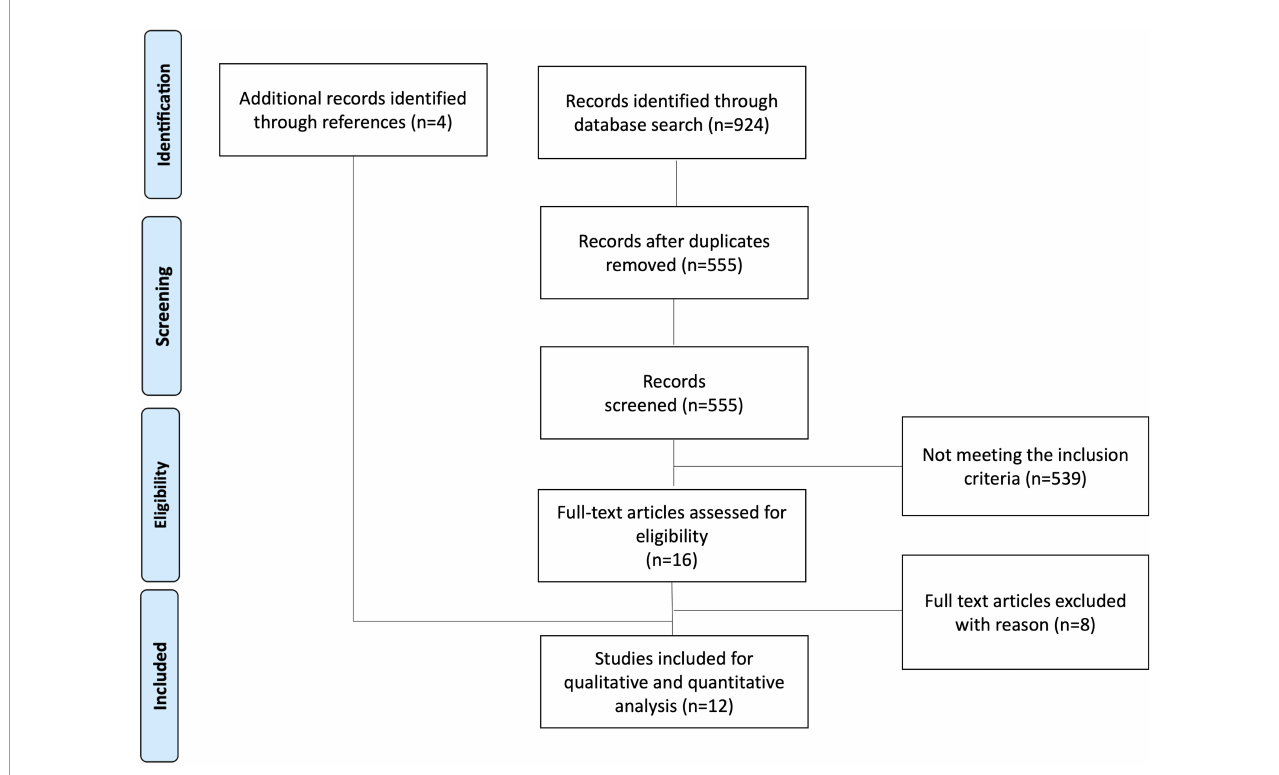
FIGURE1 Search flow chart according to PRISMA